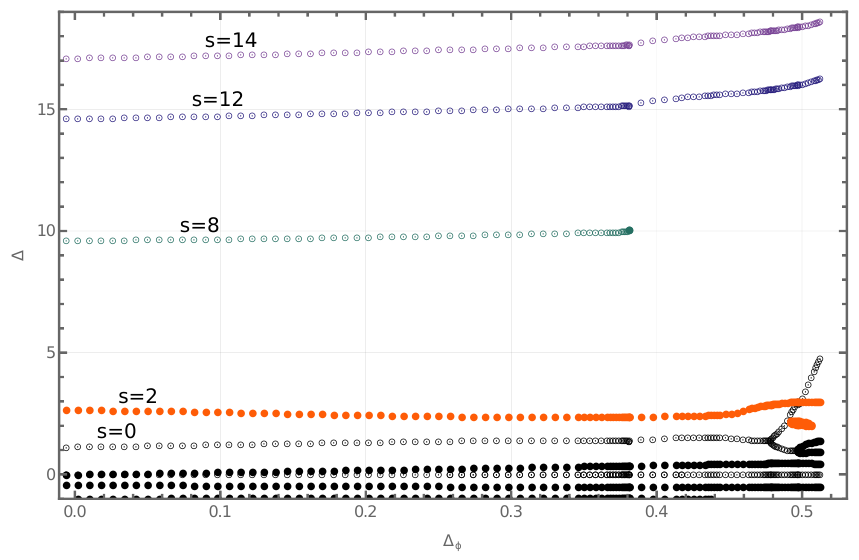
Figure 11 . Roots of the extremal functional in 3 dimensions evaluated at decreasing values of ∆ φ . Single roots are denoted by filled circles and double roots are denoted by dotted